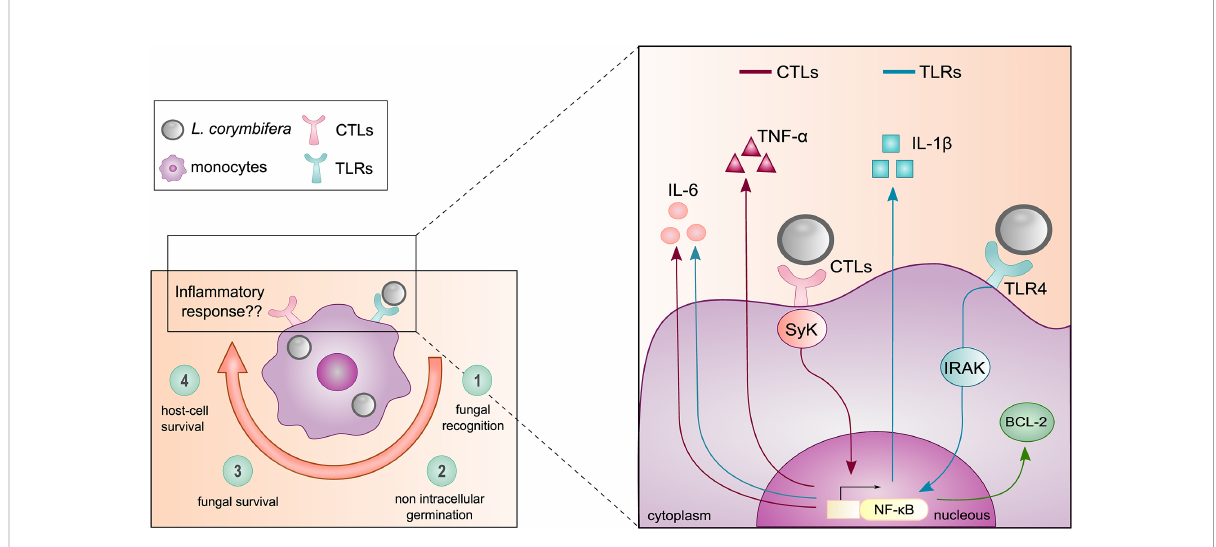
FIGURE 9 Mechanism of the monocyte in fl ammatory response against the pathogenic fungus L. corymbifera . ( Left panel ) Main fi ndings of the initial host- pathogen interactions between human monocytes and L. corymbifera spores over infection. Clockwise, 1) Recognition of the fungal spores within the fi rst hours of infection. 2,3) intracellular growth inhibition and fungal survival after 24 hours post-infection. 4) Minimal damage to the host by the fungus. ( Right panel ) Monocytic pro-in fl ammatory cytokine activation in response to L. corymbifera . The production of the pro- in fl ammatory cytokine IL-1 b is predominantly induced by TLRs (blue arrows), especially via TLR4. Whereas, TNF- a release is mediated by CTLs (red arrows), and IL-6 by synergistic activation of CTLs and TLRs (blue arrows). These signaling pathways are regulated by the transcription factor NF- k B, which also modulates the apoptotic fate of infected human monocytes by promoting the expression of the anti-apoptotic protein BCL-2 (green